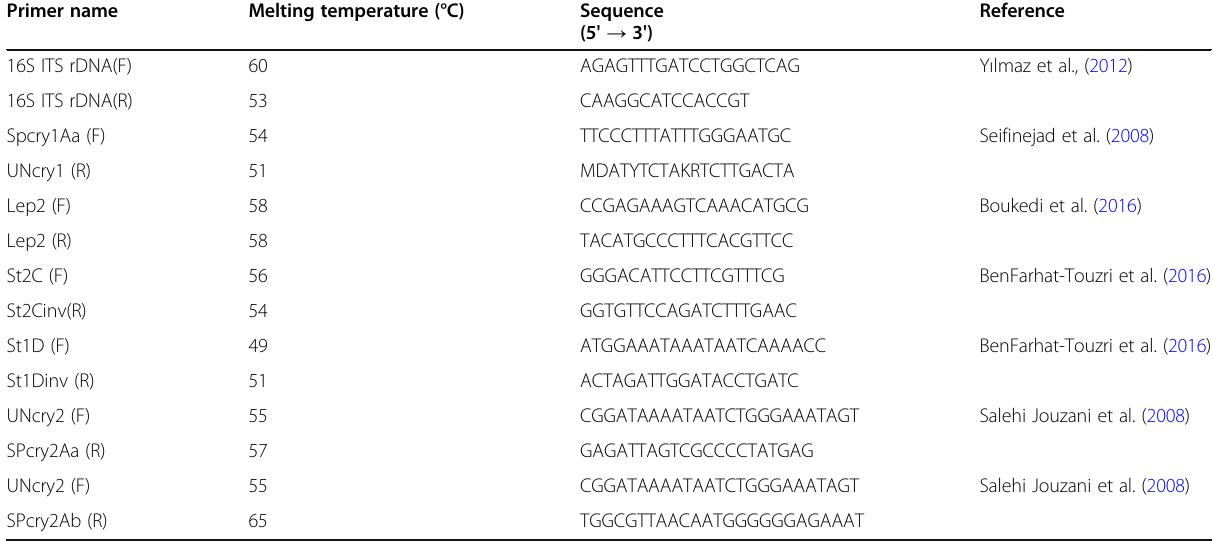
Table 1 Characteristics of primers for screening of cry -type and 16S-ITS rDNA region